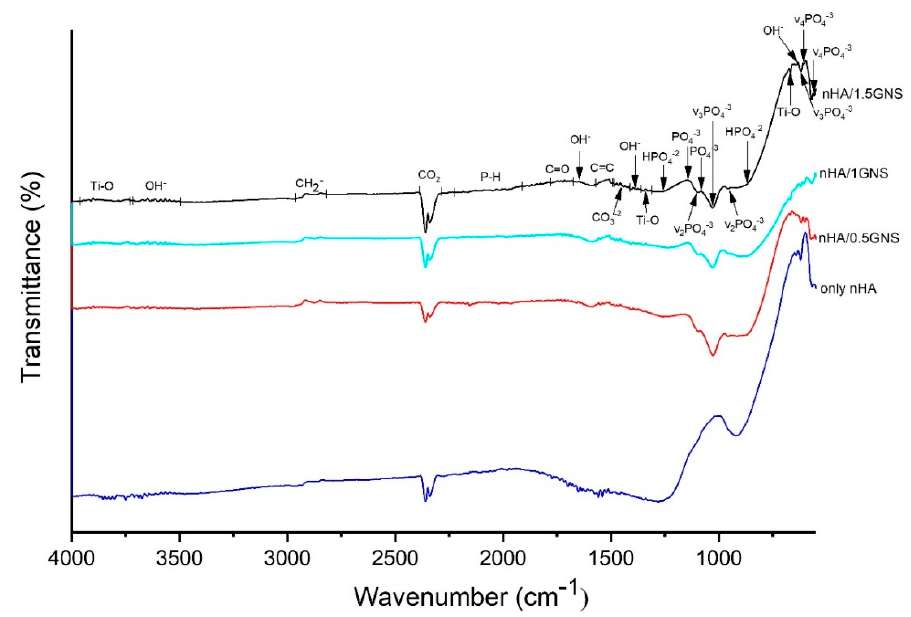
Figure 2. ATR – IR analyzed results of the nHA/GNS coated samples with different GNS additive Figure 2. ATR–IR analyzed results of the nHA/GNS coated samples with different GNS additive ratios on Ti6Al7Nb alloy. ratios on Ti6Al7Nb